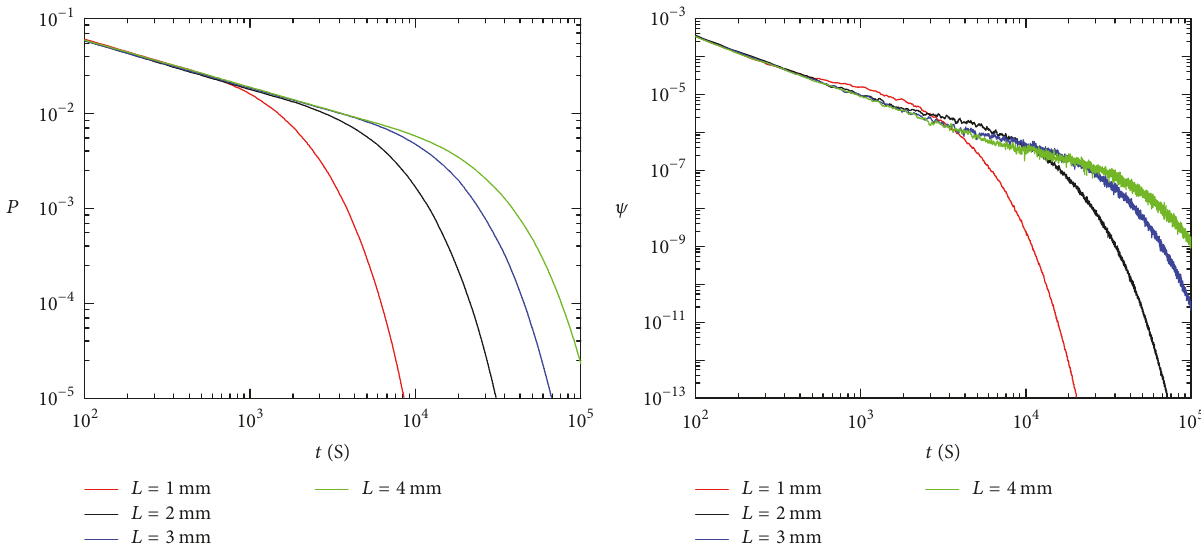
Figure 3: The deviation from the power-law decline of 𝑃(𝑡) and Ψ(𝑡) in straight tubes of different length 𝐿 as 𝑡 increases. The shorter the length is, the faster the deviation happens.